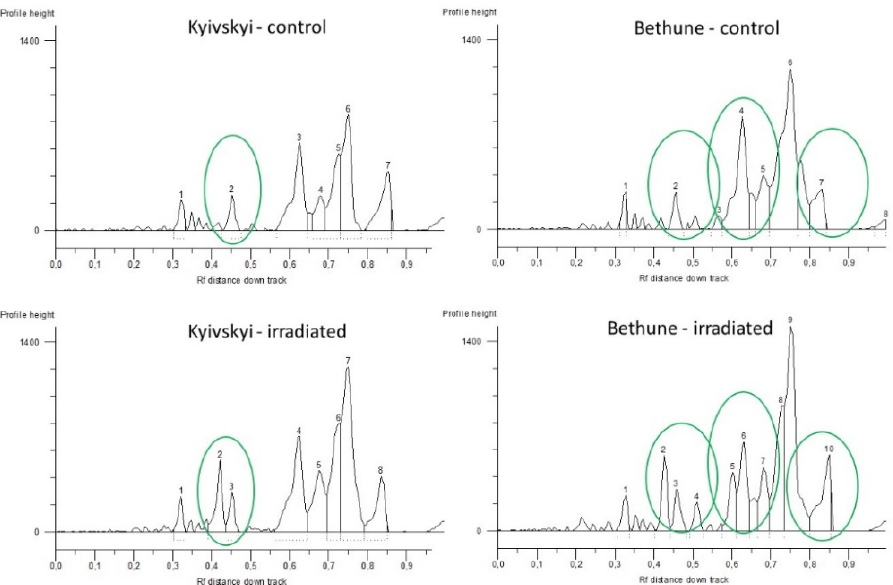
Figure 1. Comparison of obtained iPBS profiles of common flax varieties Kyivskyi and Bethune grown in the remediated and radio-contaminated field conditions of Chernobyl. x axis—Rf distance down track; y axis—profile height. 1–10—numbering of the generated loci.